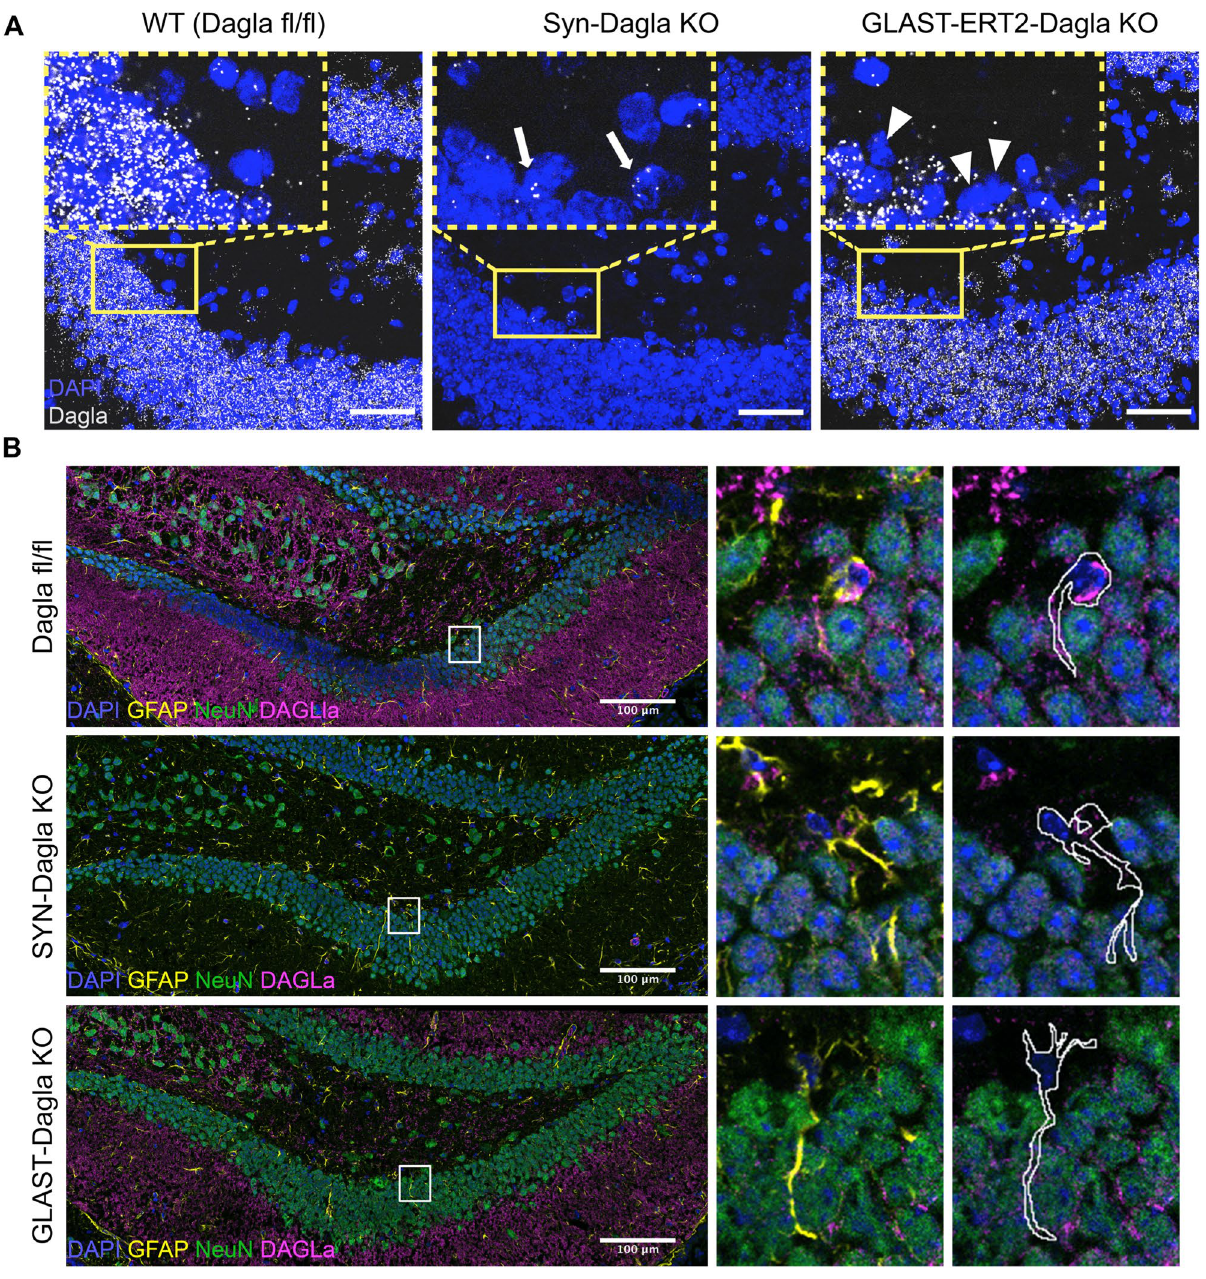
Figure 3. Dagla is deleted in the progenitor-containing subgranular zone (SGZ) in GLAST-CreERT2-Dagla KO but not in Syn-Dagla KO mice. ( A ) Representative images of an RNAscope in situ hybridisation assay detecting transcripts of Dagla (white) in the DG in the hippocampus of Dagla fl/fl control, Syn-Dagla KO and GLAST-CreERT2-Dagla KO mice. Dagla is deleted in the neuronal granular cell layer in Syn-Dagla and in the progenitor-containing subgranular zone (SGZ) in GLAST-CreERT2-Dagla KO mice (scale bar 50 µm). The magnified insets (scale bar 10 µm) show SGZ with white arrows indicating Dagla expressing cells in Syn-Dagla KO and white arrowheads Dagla -negative cells in GLAST-CreERT2-Dagla KO mice in the NSC layer (n = 3–4 animals per group). ( B ) Immunostaining detecting DAGLa (magenta) co-localization with GFAP (yellow) and NeuN (green). The magnified insets show examples of GFAP-positive cells with NSPC morphology delineated with white. Progenitors express DAGLa in Dagla fl/fl control and Syn-Dagla KO SGZ and but not in GLAST- CreERT2-Dagla KO. NeuN positive neurons in granule cell layer express DAGLa in control and GLAST- CreERT2-Dagla KO sections, but not in Syn-Dagla KO (scale bar 10